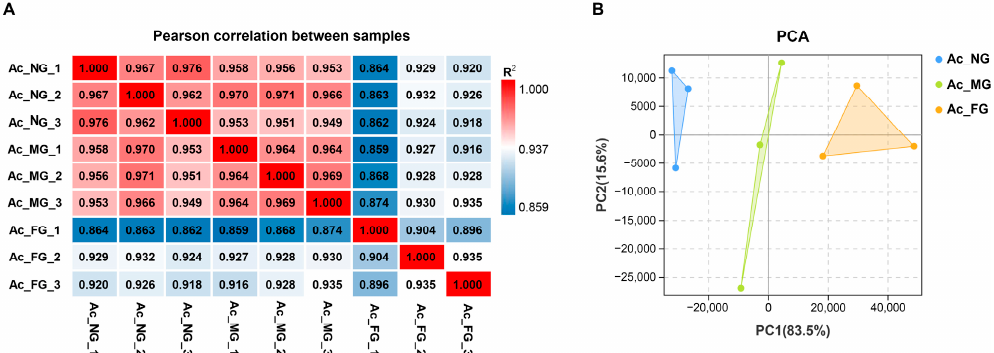
Figure 2. Correlation analysis of samples used in this study. ( A ) Pearson’s correlation coefficients between different samples. “R 2 ” represents the square of Pearson’s correlation coefficient. ( B ) Principal component analysis (PCA). NG: nonbreeder gonad; MG: male gonad; FG: female gonad.